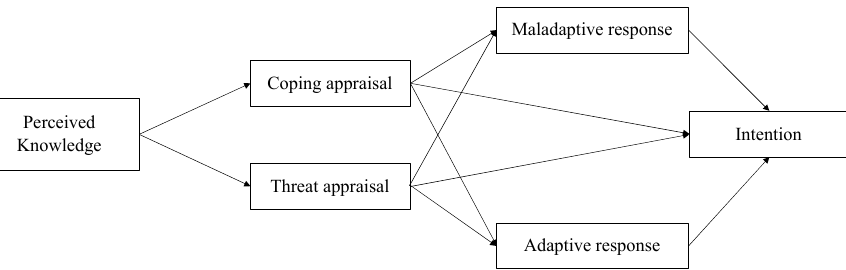
Figure 1. Proposed model utilizing protection motivation theory (PMT) to explain the intention to get COVID-19 vaccinated.